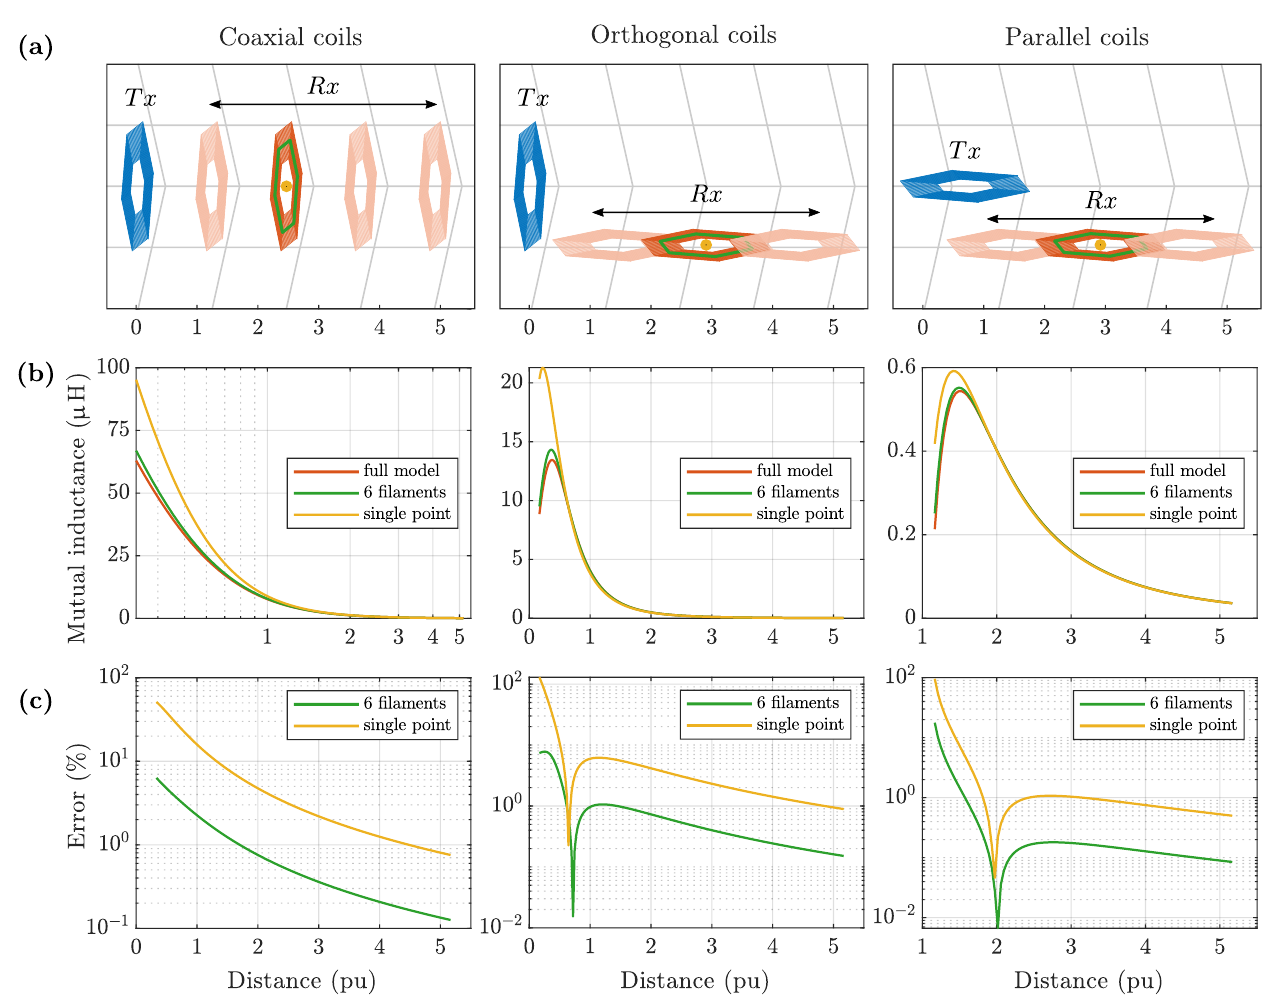
Figure 12. ( a ) A transmitter coil, Tx , and a receiver coil, Rx , at increasing distance, for three orientation configurations. Plots are on a per unit (p.u.) scale, referring to the coil diameter. ( b ) The mutual inductance was calculated with the full model, 6-filament and single-point approximations. ( c ) The relative error falls below 1% at a distance of larger than 2p.u. and 5p.u. for the 6-filament and single-point models, respectively, for all the three orientations